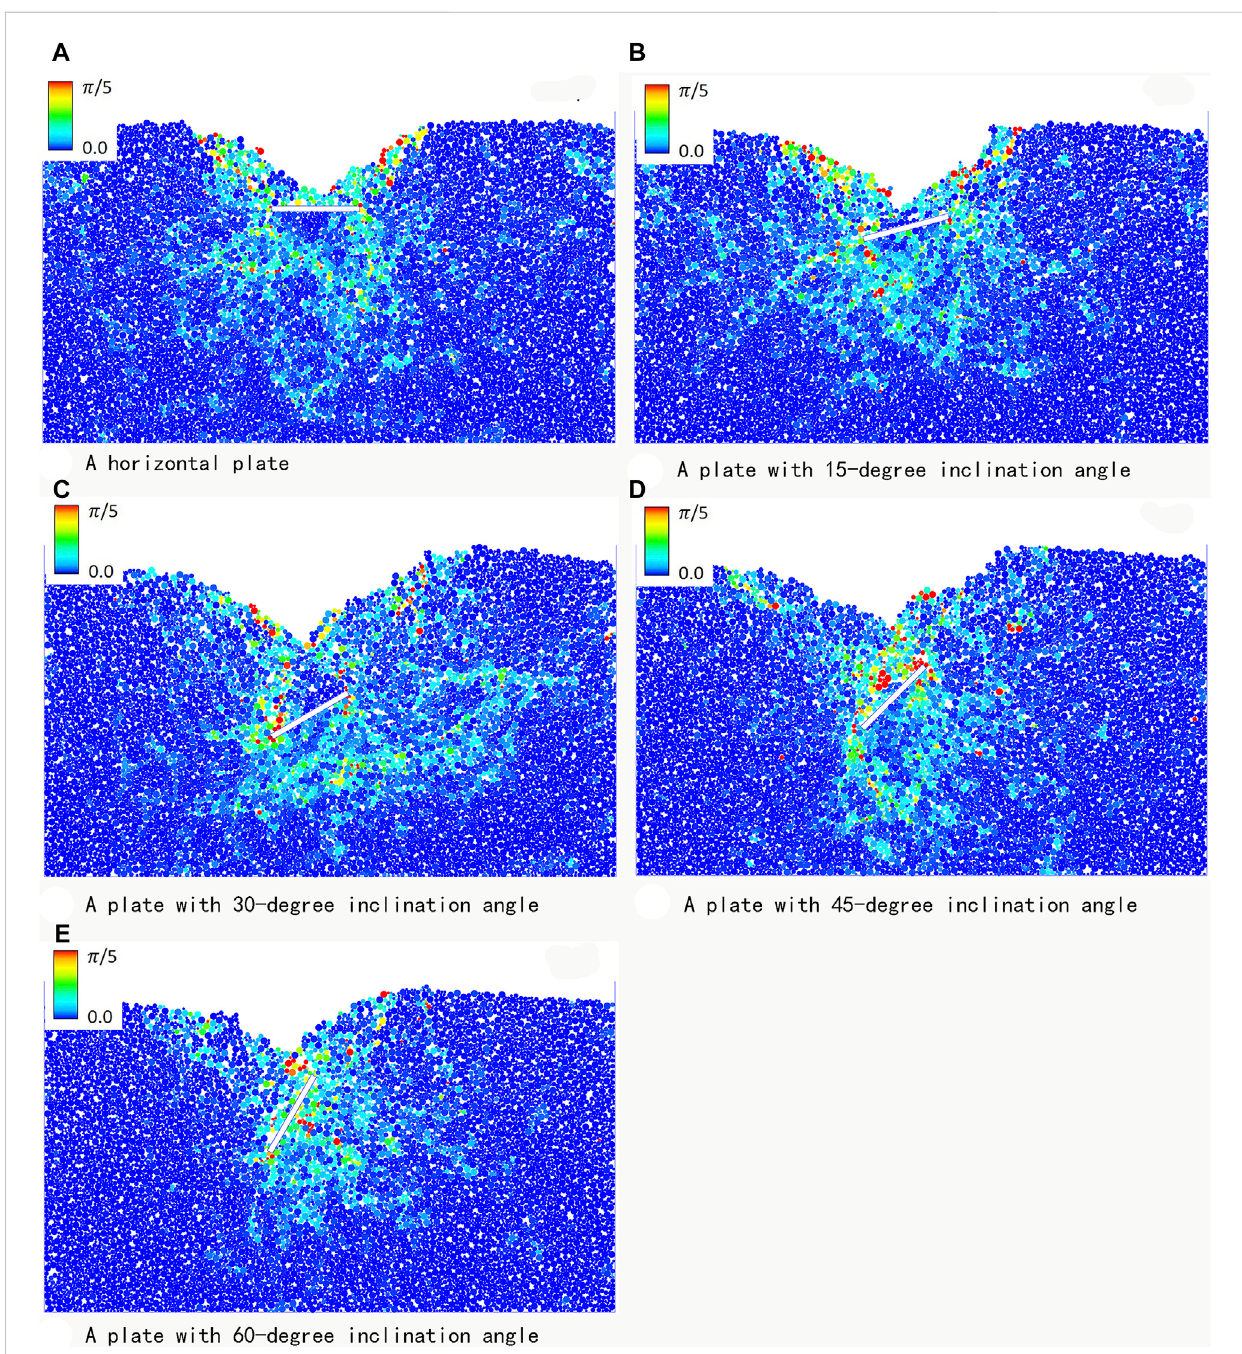
FIGURE 10 Penetration band formation of soil elements when plate varied inclination angles. (A) A horizontal plate. (B) A plate with 15-degree inclination angle. (C) A plate with 30-degree inclination angle. (D) A plate with 45-degree inclination angle. (E) A plate with 60-degree inclination angle.